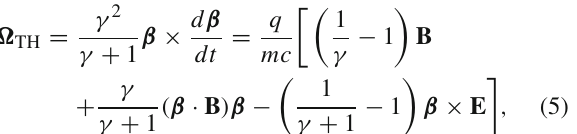
Fig. 2 Outgoing angular distributions at various momenta for protons andantiprotonsimpingingona1mm longSicrystalbentalongthe(110) plane by a 0.1mrad bending angle. The dechanneling length for posi- tive particles in straight crystals ( L d ) and in the bent crystal ( L d ( R ) ), along with the critical radius for channeling ( R c ), are calculated for the different momenta following Ref. [19]